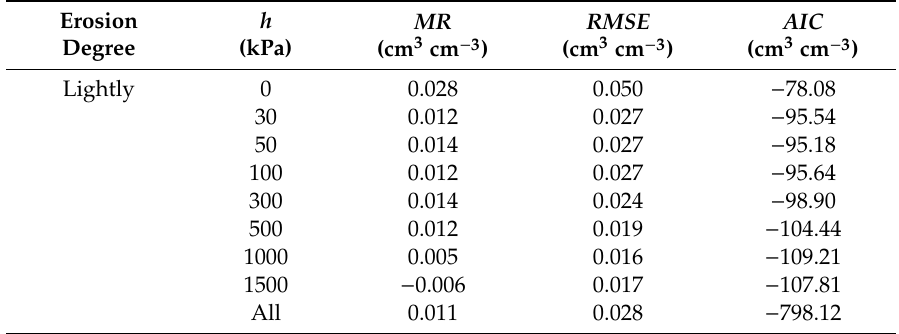
Figure 3. ( a ) Measured soil water contents and simulated soil water characteristic curve (SWCC) for di ff erent eroded soils; ( b ) Measured and simulated soil water contents for di ff erent eroded soils. Table 5. MR , RMSE and Akaike’s information criterion ( AIC) between simulated and measured soil water contents for the lightly and the severely eroded